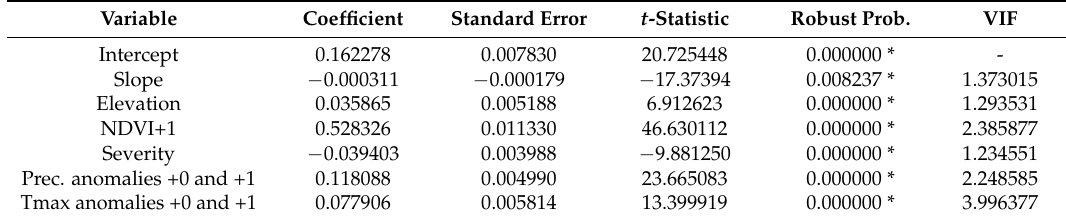
Table 6. OLS results for other Pinus ( P. nigra and P. pinaster ) at 95% confidence interval. Variable Coefficient Standard